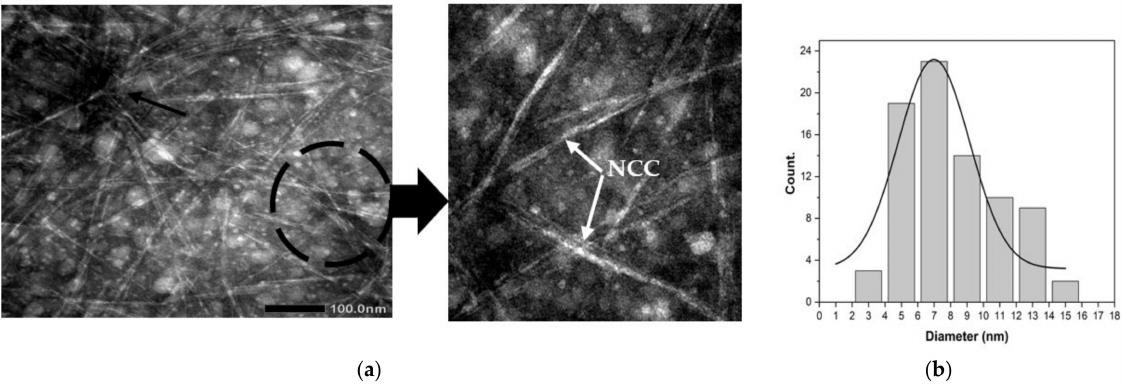
Figure 4. ( a ) TEM micrograph of NCC extracted from tea waste. ( b ) Diameter distribution of NCC extracted from tea